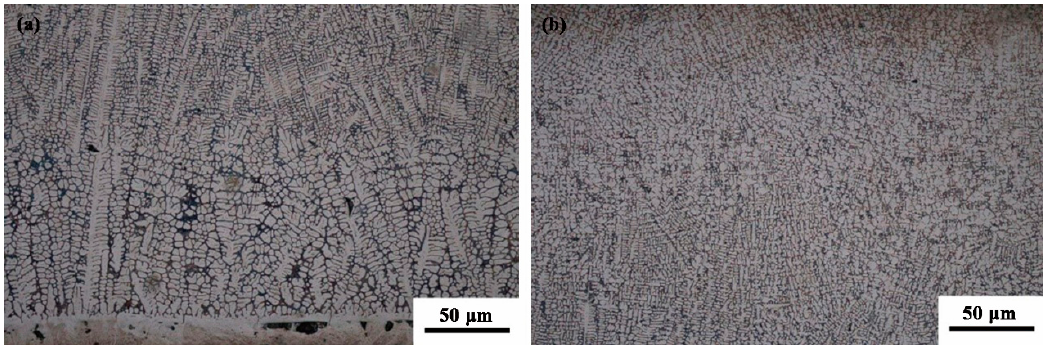
Figure 6. The morphology of the cladding layer: ( a ) bottom; ( b ) middle.